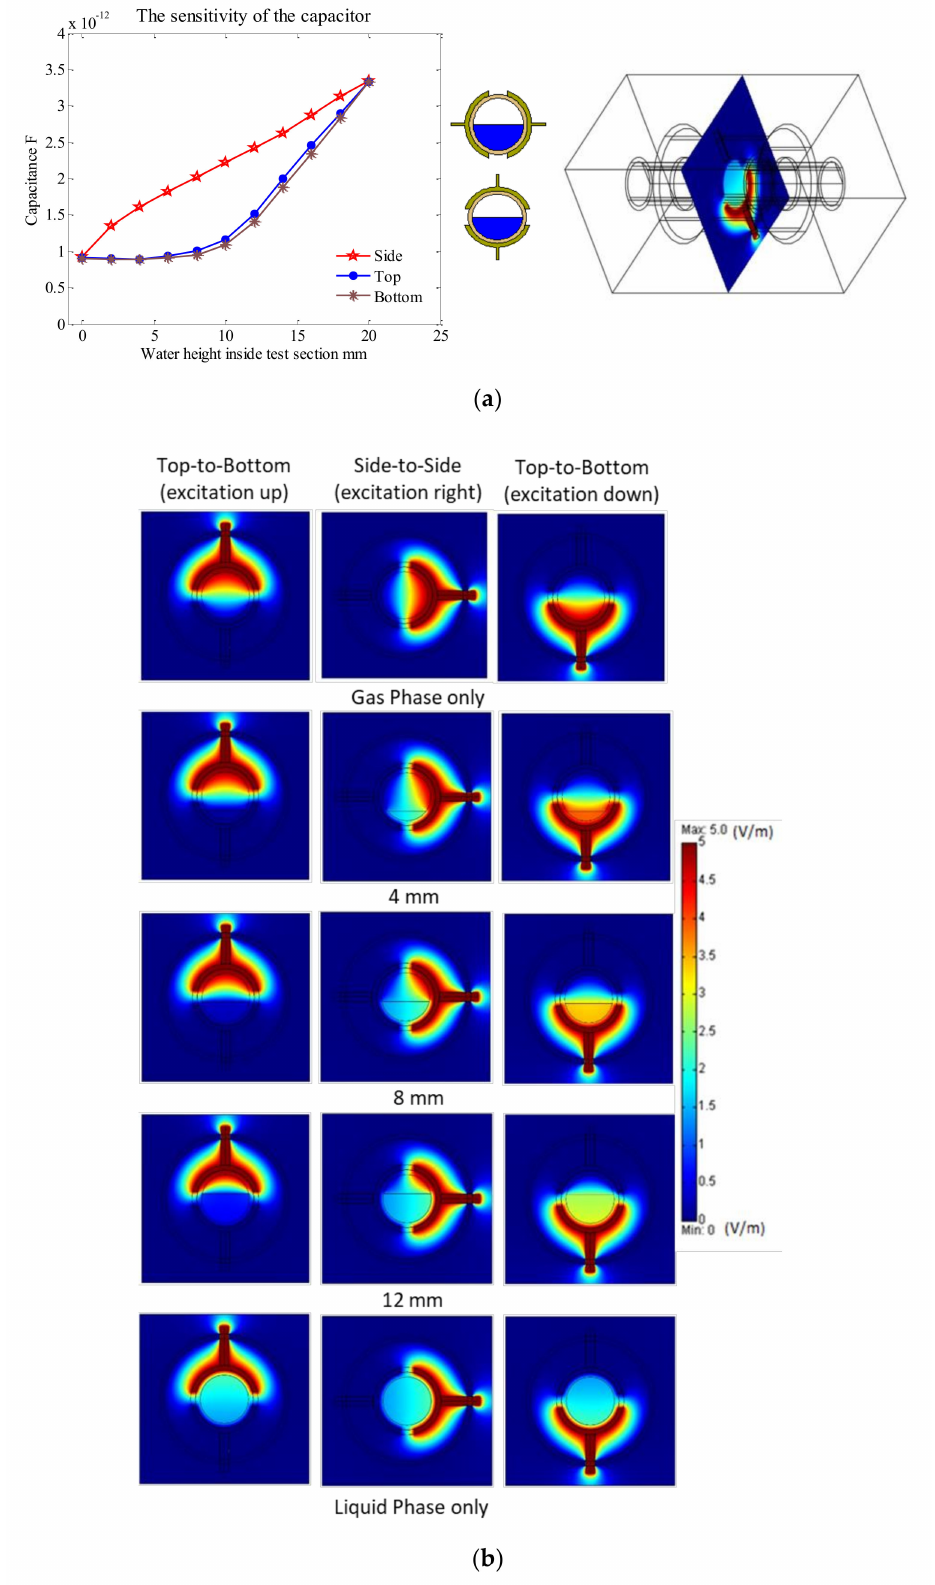
Figure 14. Numerically investigating the di ff erent orientations of the utilized concave two-electrode sensor around the pipe: ( a ) the capacitance values and ( b ) the electromagnetic spectrum as a function of water